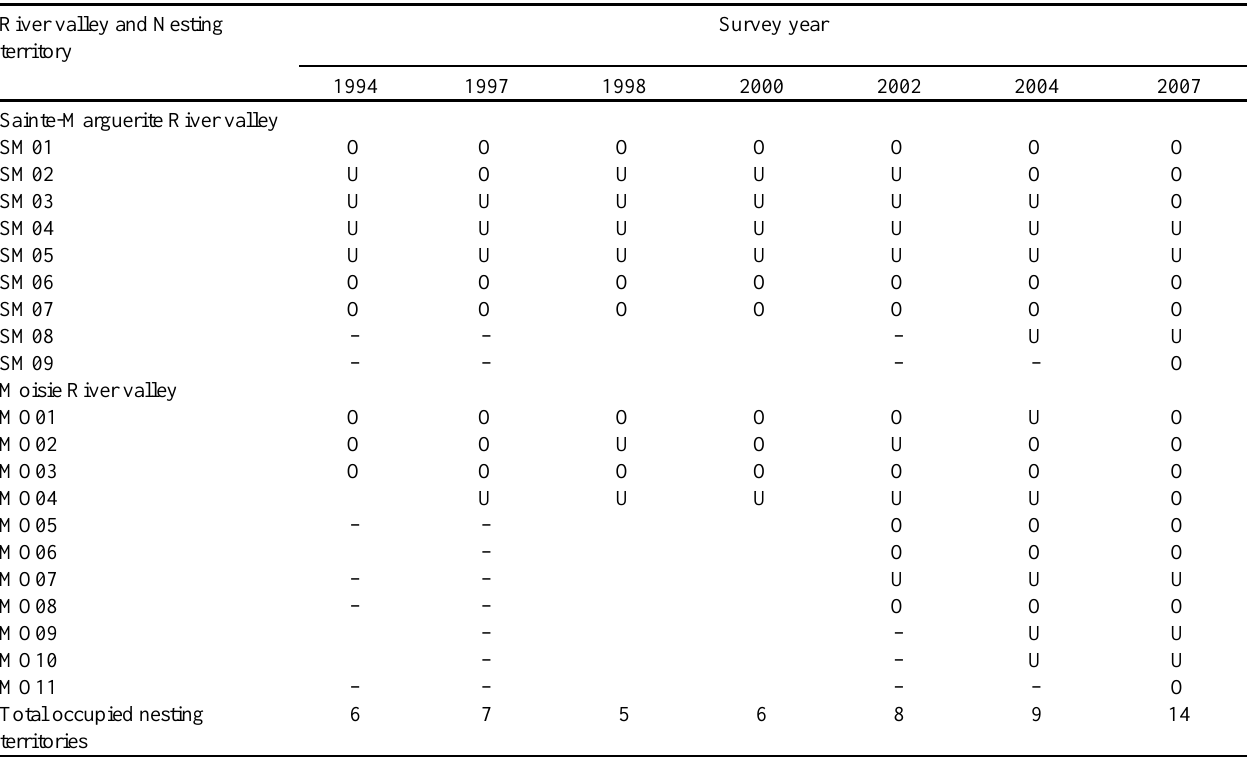
Table 1 . Nesting territory occupancy by pairs of Golden Eagles ( Aquila chrysaetos ) in the Sainte-Marguerite and Moisie River valleys, 1994-2007 (O = Occupied; U = Unoccupied; – = surveyed but not spotted, either because there were no nests or they were not seen; blank space = not